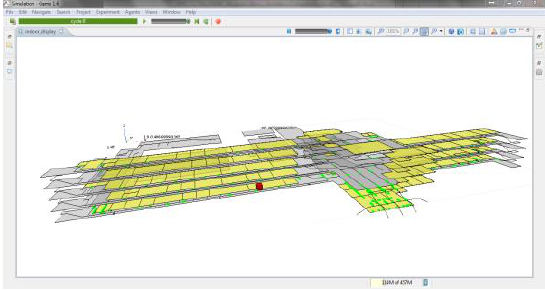
Figure 5. A screen capture image of the GAMA simulation experiment window showing the 3DGIS building